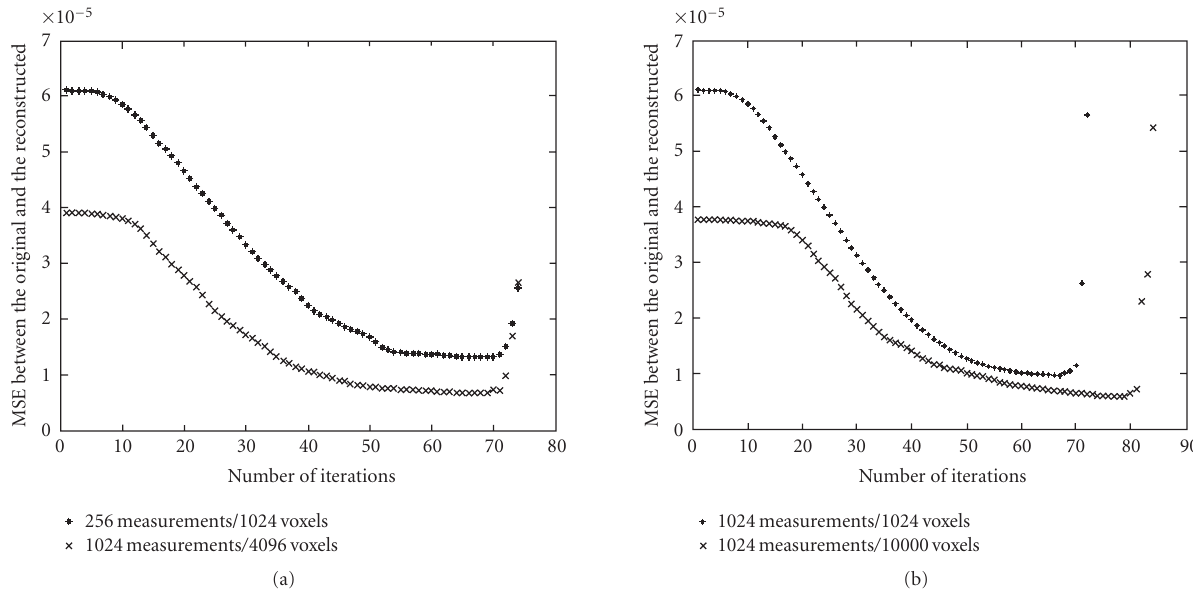
Figure 2: Number of iterations versus MSE (mean squared error) between the original and the reconstructed. (a) shows the MSE for datasets of 256 ∗ 1024 and 1024 ∗ 4096. Although the size is di ff erent, the iterative number where the MSE increases is the same, since they have the same value of n/m . Two datasets in (b) have the same number of measurements 1024, however, the MSE with 10000 voxels increases much later than the one with 1024